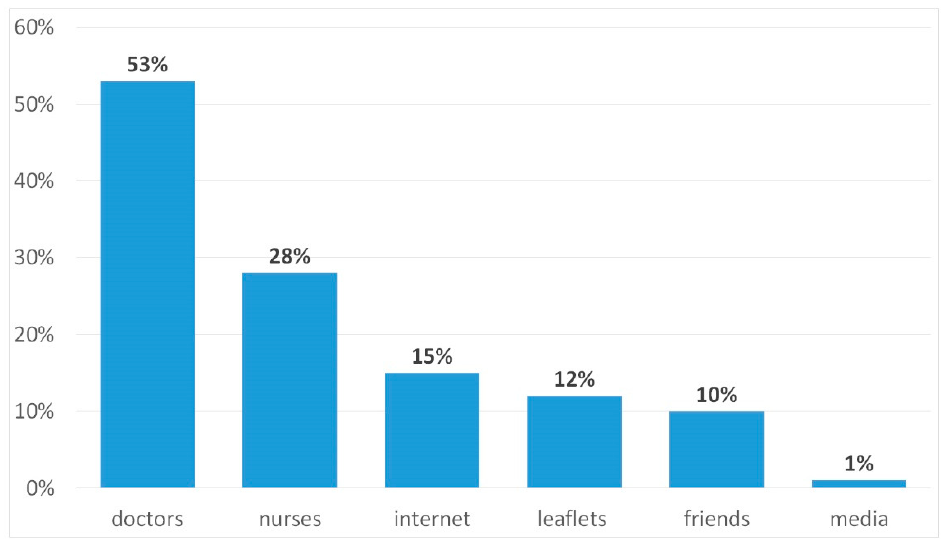
Figure 2. Sources of information about vaccinations.